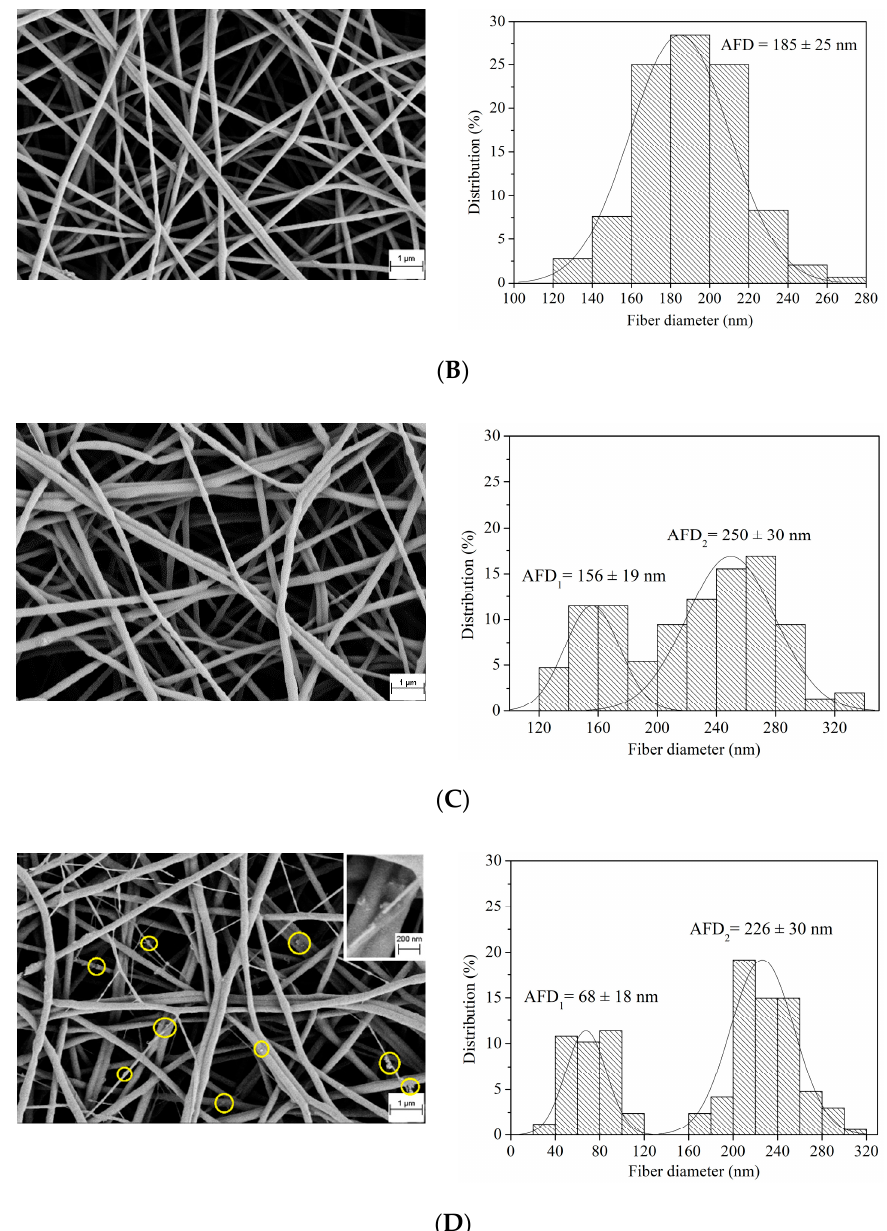
Figure 1. SEM micrographs and diameter distribution of PEO / AVE nanofibers. ( A ) PEO; ( B ) PEO / AVE 5 wt%; ( C ) PEO / AVE 10 wt%; ( D ) PEO / AVE 20 wt%. Yellow circles in Figure 1D indicate AVE particles.